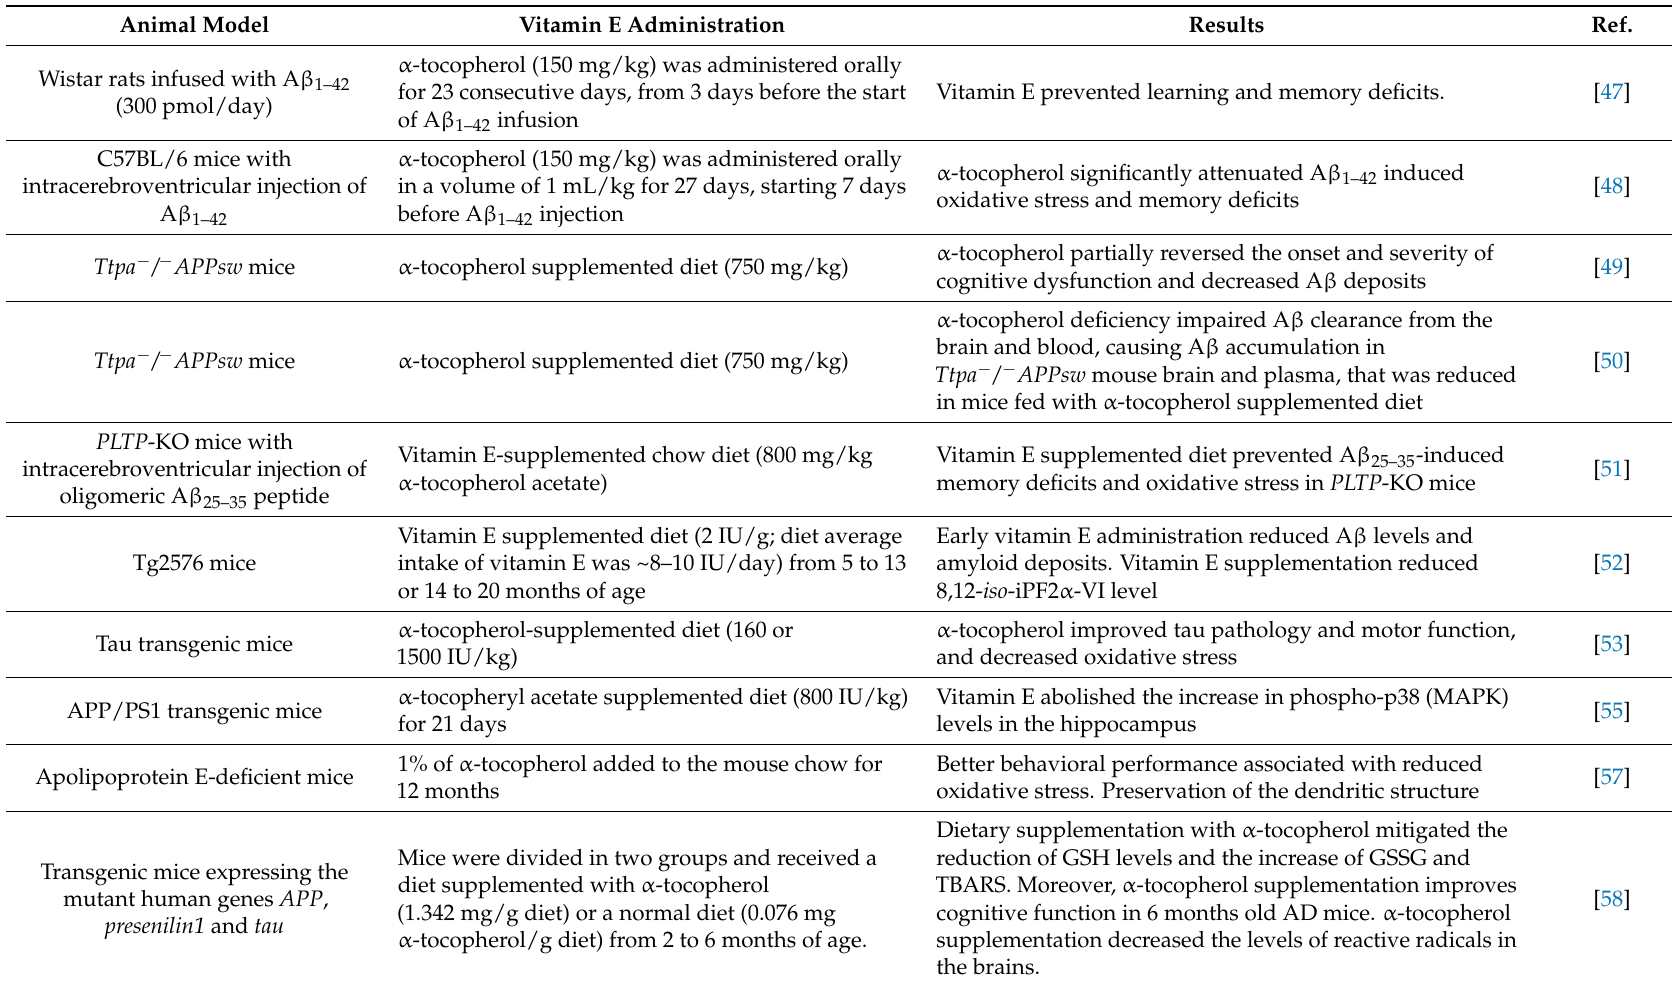
Table 1. Experimental studies evaluating vitamin E